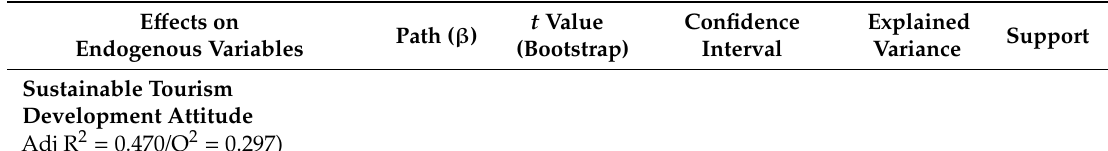
Table 4. Direct e ff ects on endogenous